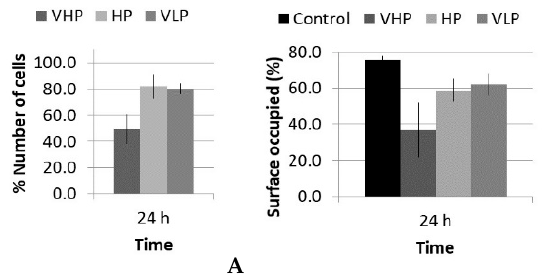
Figure 7. % ( A ) Number of cells and ( B ) surface occupied, with respect to control, 24 h after treatment with the long pulse protocol.